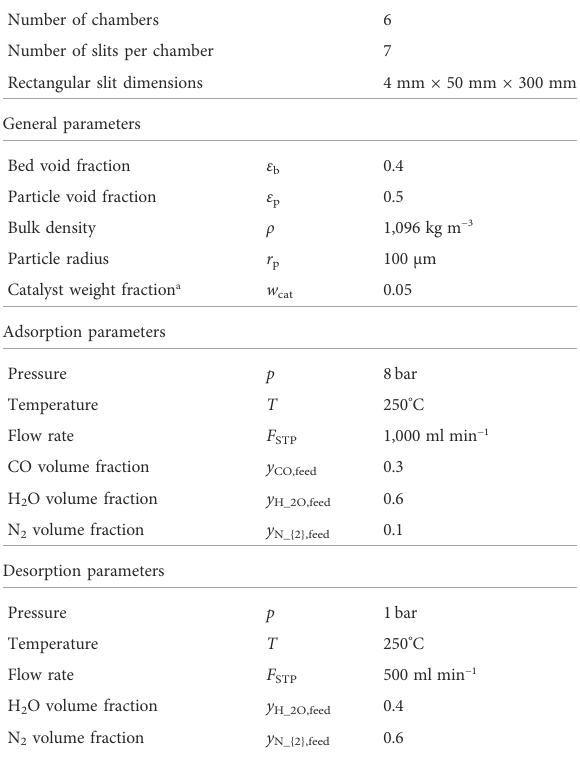
TABLE 2 Parameters and operating conditions used in the pilot plant base case